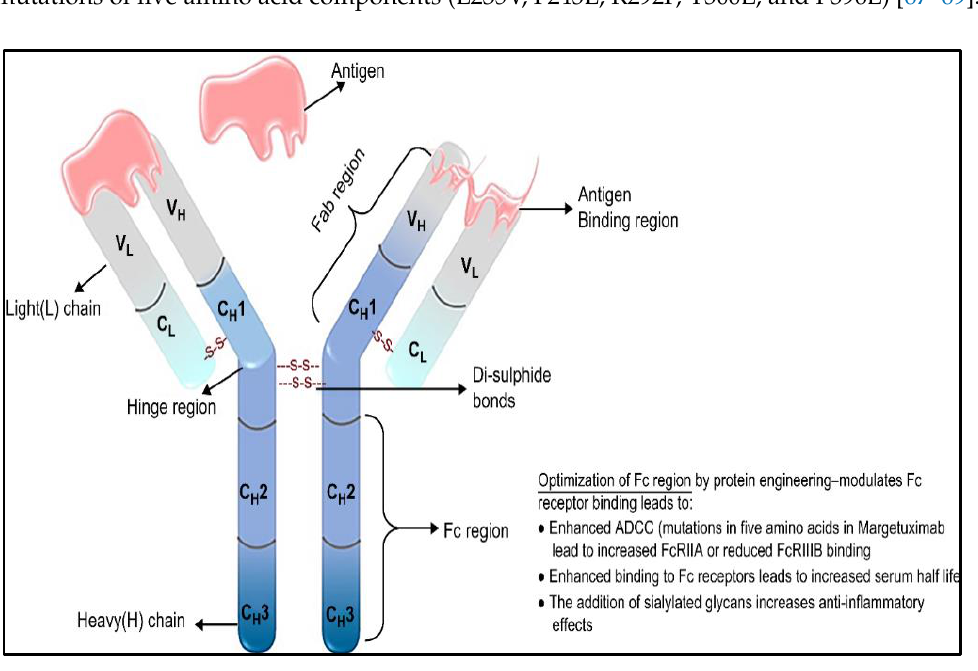
Figure 2. Schematic representation of margetuximab. Margetuximab is a chimeric IgG1 kappa mAb with an optimized Fc region to enhance binding. The Fab and the Fc regions of IgG1 are indicated using brackets. Heavy chain domains are represented by C H 1 to C H 3, whereas light chain domains are denoted by C L . V H and V L represent the variable heavy chain and variable light chain, respec- tively.